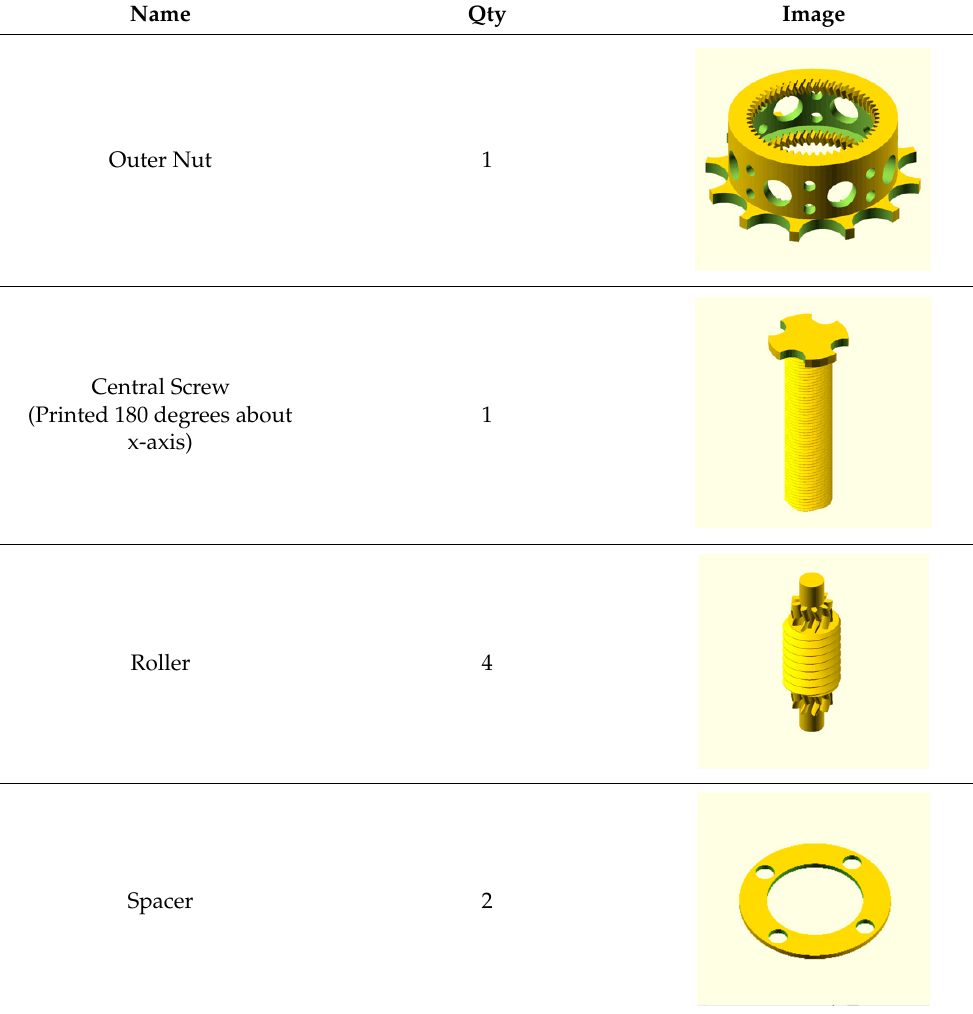
Table 5. BOM of test stand